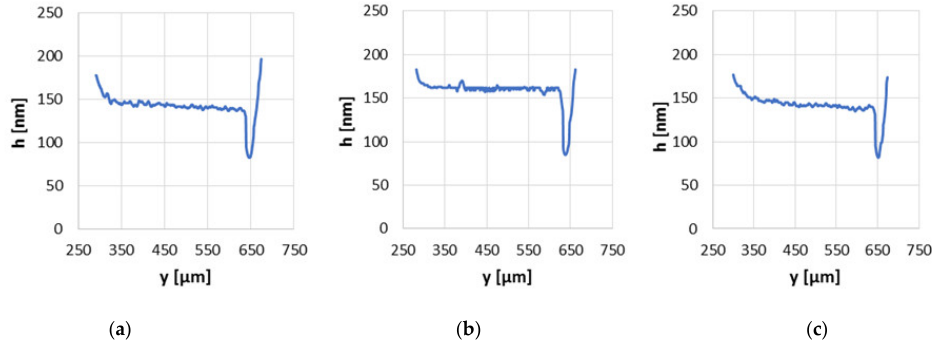
Figure 9. Oil film thickness distribution graphs in non-conformal contact with load of 20 N and sliding velocity of 0.1 m/s for the base surface ( a ), modified surfaces no. 2 ( b ) and no. 3 ( c ).